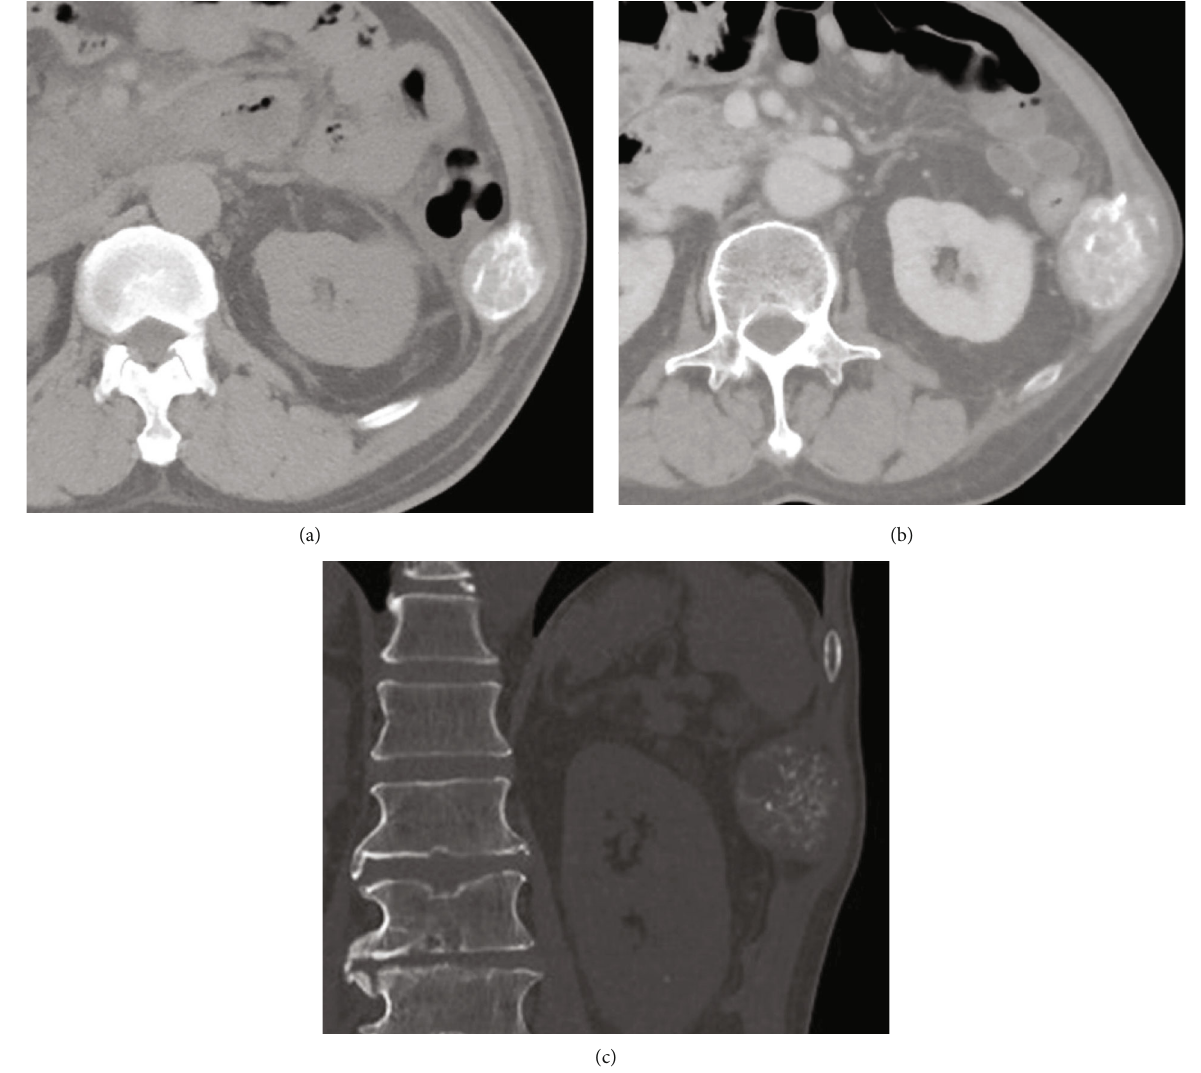
Figure 1: (a) Computed tomography (CT) image of the tumor showing cortical destruction and calci fi cation in the 11th rib. (b) The tumor slowly grew at three-year intervals. (c) Calci fi cation resembled the ring and arc calci fi cations observed in chondrosarcoma on